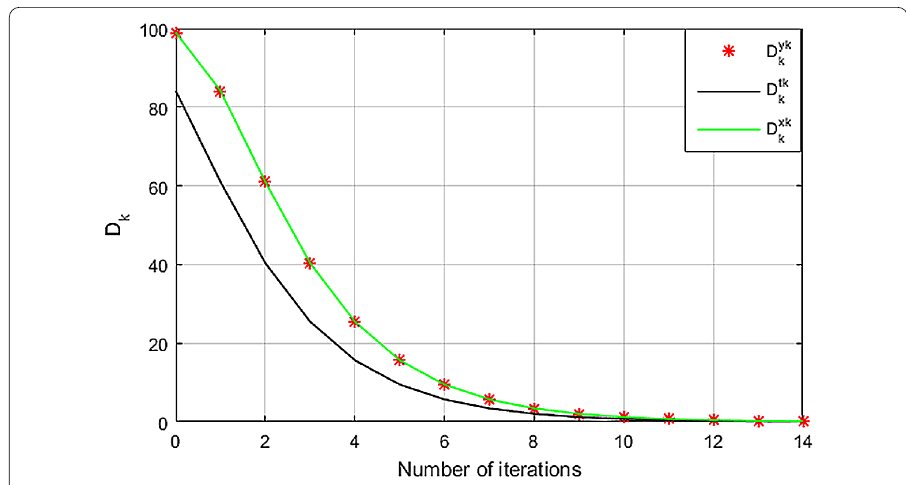
Figure 1 Convergence of iteration